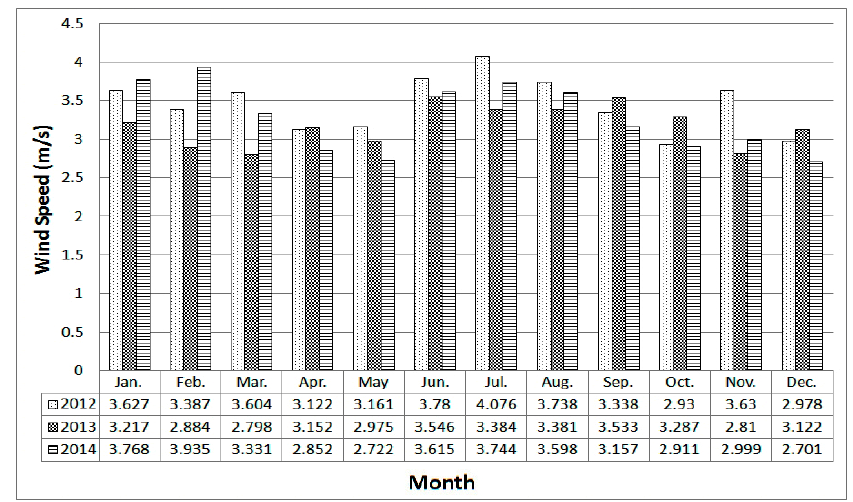
Figure 14. The increased wind velocity in the presence of the optimized V-shaped roof guide vane (VRGV) structure at the region of the wind turbine in Subang (m/s) (2012–2014).